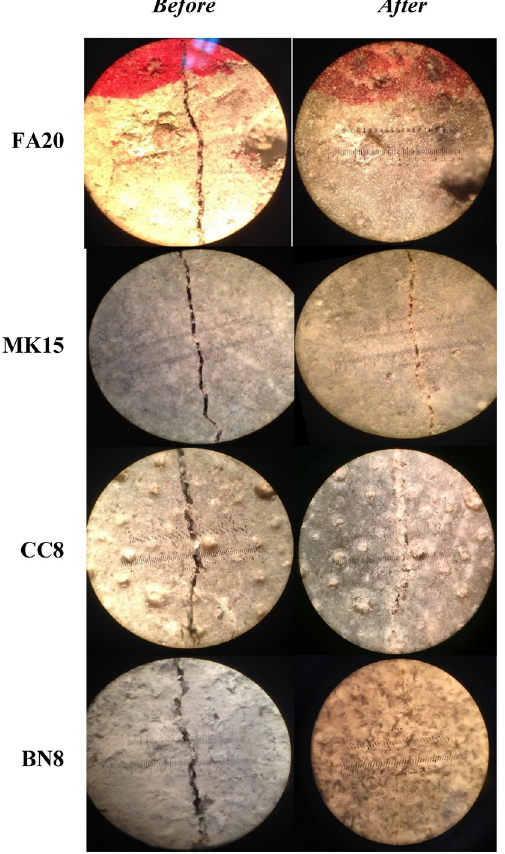
Figure 8. Initial cracked surfaces and status after water submersion exhibiting self-healing.